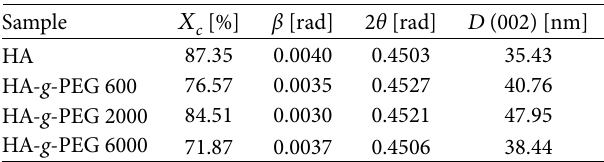
Table 2: Crystallinity [ 𝑋 [%]] and crystal size [ 𝐷 [nm]] of HA and 𝐶 HA- g -PEG systems based on XRD characterization ( β —the peak width at half height